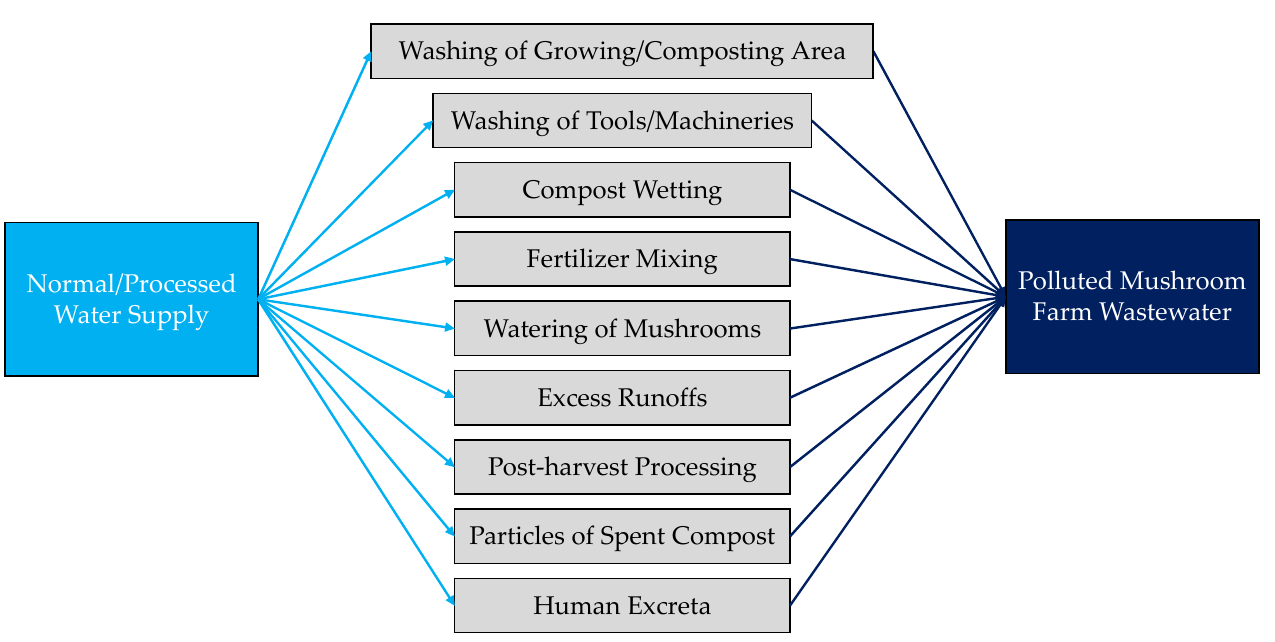
Figure 1. Various activities and sources of pollutants in wastewater released from mushroom farms.